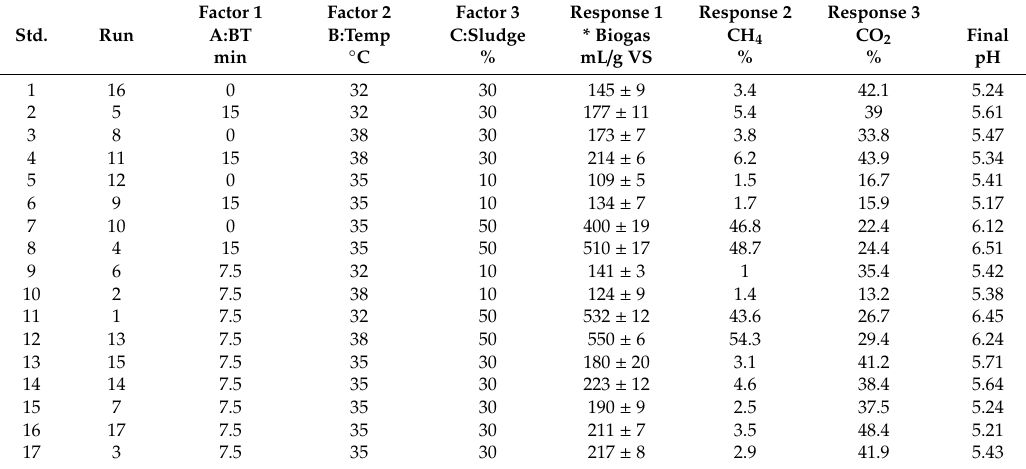
Table 6. Design matrix for AD of pot